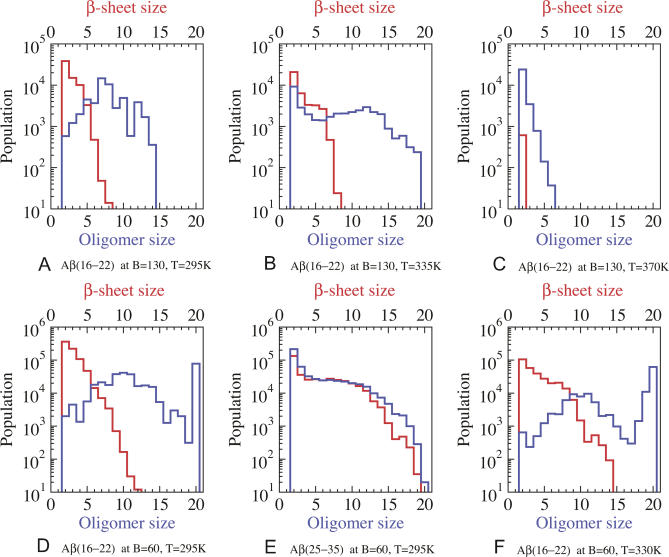
Populations of Oligomers and β SheetsPopulations of oligomers (blue) and β sheets (red) as a function of the oligomer and β sheet size for different concentrations and temperatures Aβ16–22, box size B = 130 and temperature T = 295 K (A).(B) Aβ16–22, box size B = 130 and temperature T = 335 K.(C) Aβ16–22, box size B = 130 and temperature T = 370 K.(D) Aβ16–22, box size B = 60 and temperature T = 295 K.(E) Aβ25–35, box size B = 60 and temperature T = 295 K.(F) Aβ16–22, box size B = 60 and temperature T = 330 K.